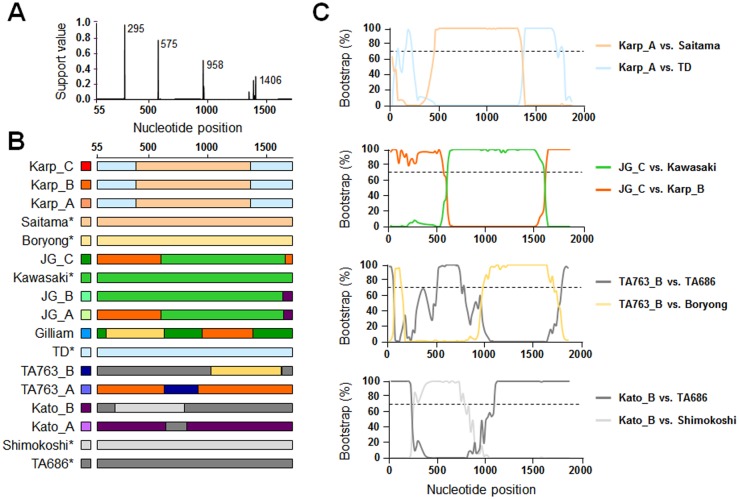
Detection of intragenic recombination in tsa56 genes using 17 proto-genotype sequences.A. Recombination breakpoints within tsa56 sequences were detected using the GARD program. Support probabilities for inferred recombination break-points are shown on the left side of the breakpoint plots. B. Intragenic recombination events in tsa56 sequences found using the RDP suite. The schematic diagrams of indicated genotypes present the putative major and minor parent sequences of each genotype (by color codes) and the location of predicted breakpoints. Detailed information of the recombination events predicted by the RDP suite is summarized in S6 Table. The genotypes without significant recombination are marked with (*). C. Representative BOOTSCAN evidence for recombination origin on the basis of pairwise distance, modeled with a window size 200 nt, step size 20 nt, and 100 Bootstrap replicates. The threshold of significance for the analysis was set as 70% bootstrapping value (dash line).